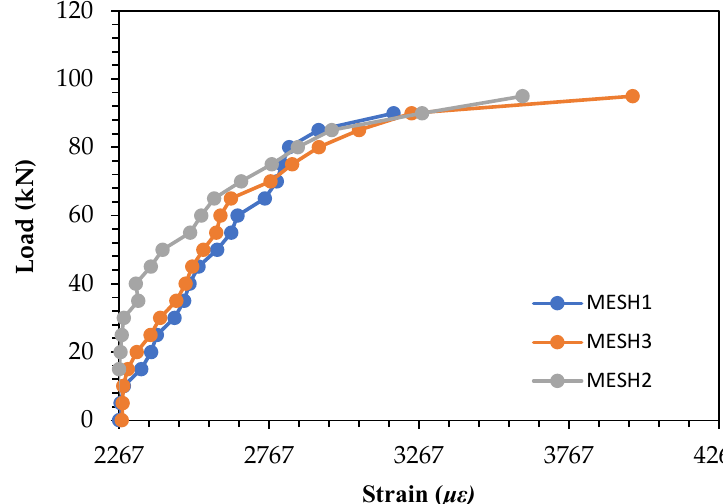
Figure 15. Load vs. Strain for NWC and LWC beams.